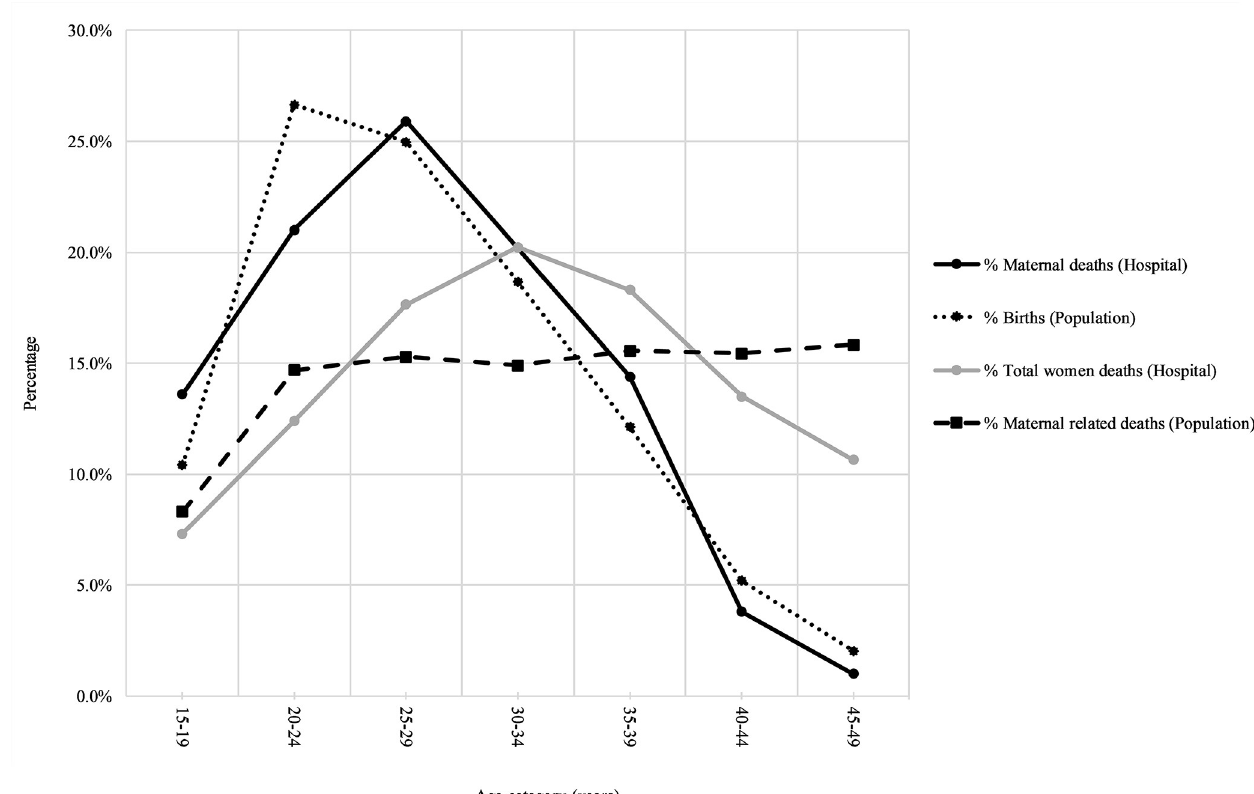
Fig 1. Percentage of birth, total women deaths and hospital maternal deaths by age category (Total women hospital deaths = 40,052; Hospital maternal deaths =